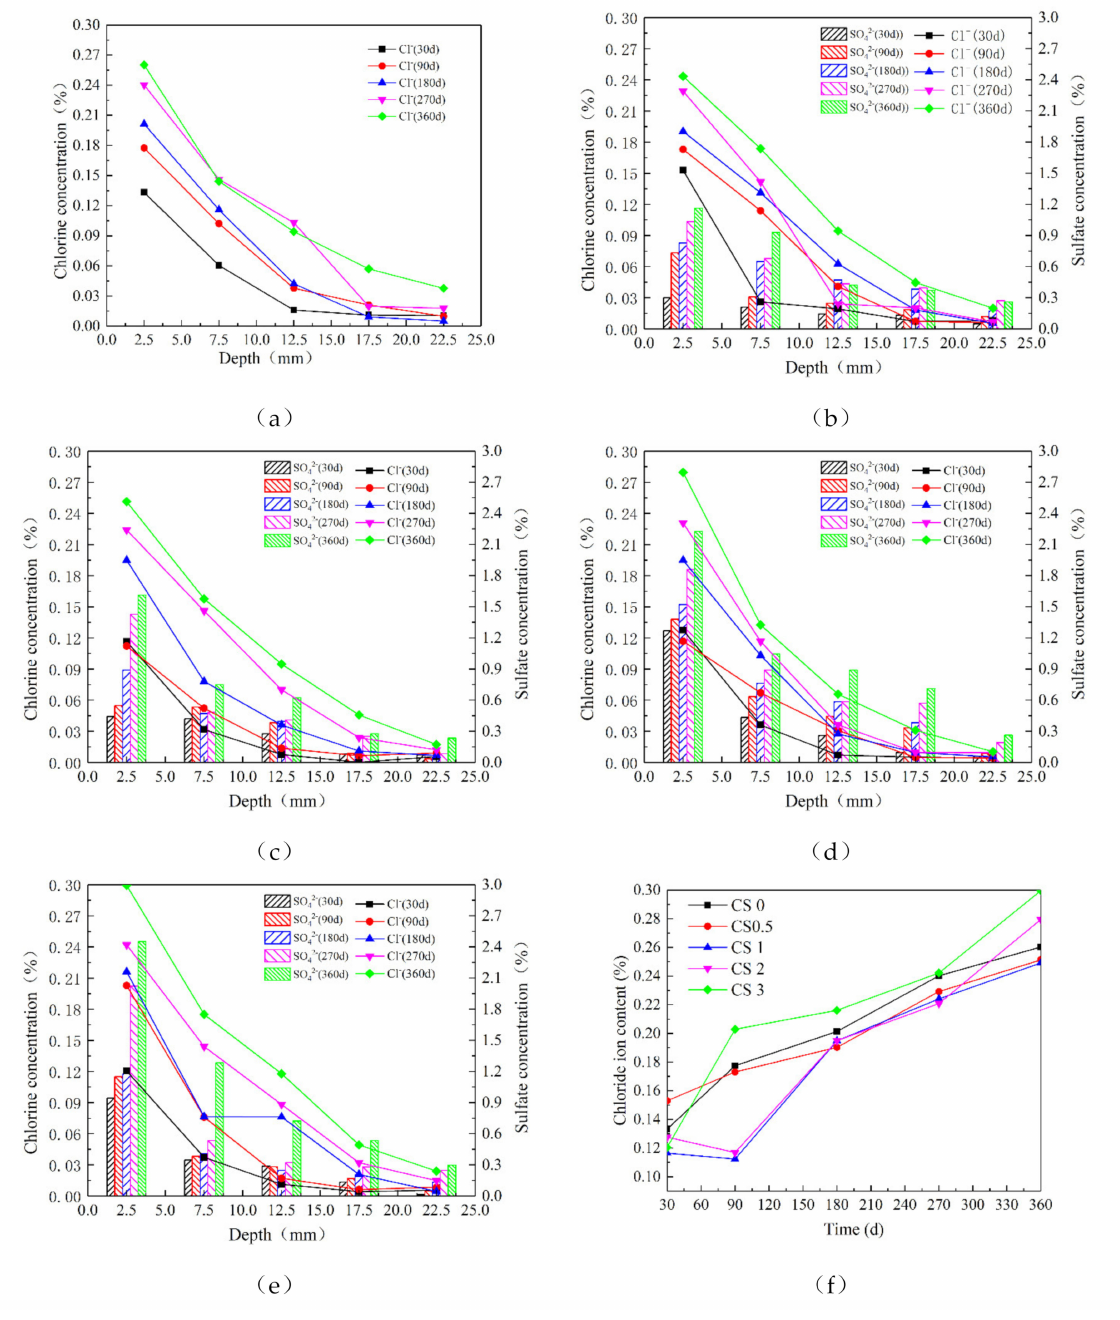
Figure 7. Results of Cl − and SO 4 2 − concentrations: CS0, CS0.5, CS1, CS2, and CS3 ( a – e , respectively), and ( f ) ion content at 2.5